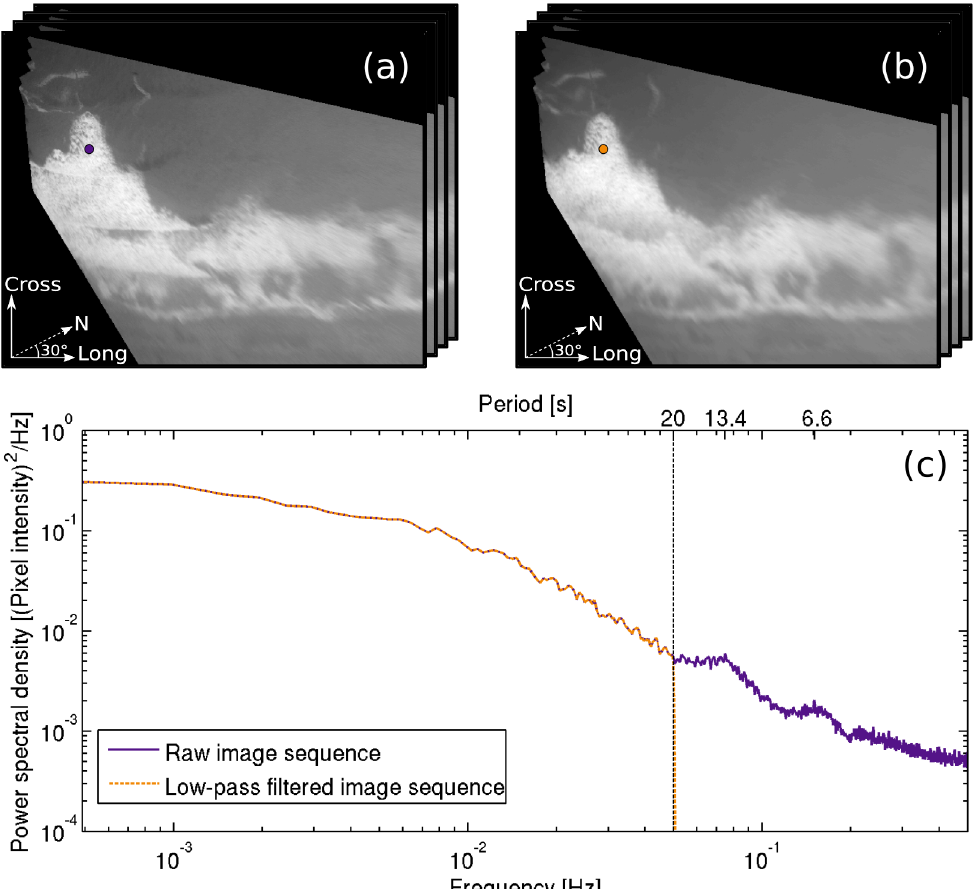
Figure 4. Surface gravity waves removal from images. ( a ) Raw rectified image sequence containing visible waves; ( b ) rectified image sequence after wave-filtering. ( c ) Pixel intensity power spectral density (PSD) computed at the image location of the ADCP (purple and orange dot). The PSD is computed from the raw image time series (purple line) and the low-pass filtered image sequence (orange dashed line). The black dashed line corresponds to the cutoff frequency (1/20 Hz) of the low-pass filter previously applied to the raw image